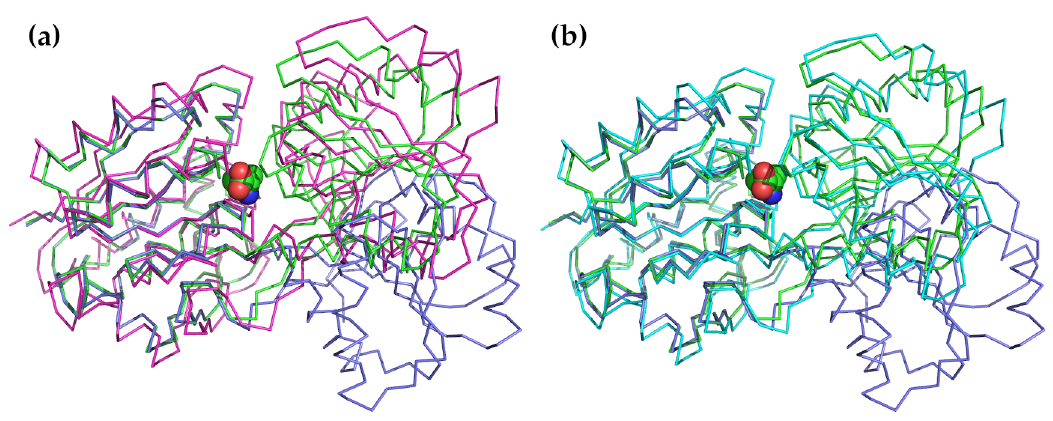
Figure 2. An illustration of how the conformational change between the open and substrate-bound forms of LivJ can be described using only a few low-frequency modes. The NMA was carried out on the open, unbound form of LivJ using the offline form of ElNémo [20,68]. In both panels, the unbound form is shown in purple, the substrate-bound form is shown in green, and the valine substrate is shown as Van der Waals spheres. ( a ) Most of the substrate-bound conformation can be reproduced by applying the lowest-frequency mode to the open form. The magenta structure shows the results of applying only the lowest-frequency mode to the open form of LivJ. The RMSD between this conformation and the substrate-bound form is 2.3 Å as compared to 6.5 Å between the open and substrate-bound forms. ( b ) The closed form can be even more closely approximated using a combination of five of the lowest-frequency modes (cyan). The RMSD between this form and the substrate-bound form is only 1.5